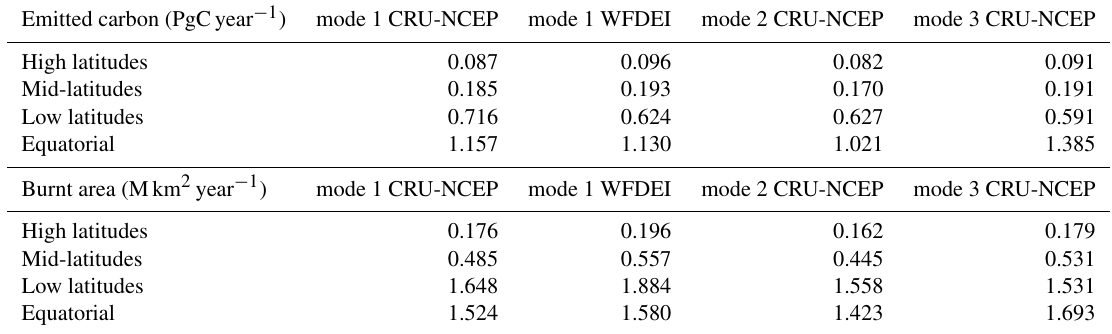
Table 2. Mean yearly emission budgets in Peta-grams of emitted carbon and mean yearly burnt area budgets in millionkm 2 for the 1997–2010 period. Latitudes were bound to beyond 50 ◦ (high latitudes), 35 to 50 ◦ (mid-latitudes), 15 to 35 ◦ (low latitudes) and below 15 ◦ (equatorial). Four configurations of INFERNO are presented, with CRU-NCEP and WFDEI driving meteorology coupled with three ignition modes: mode 1 indicates constant anthropogenic and lightning ignitions, mode 2 is for constant anthropogenic with interactive lightning ignitions, and mode 3 for interactive lightning and anthropogenic